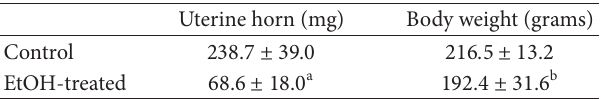
Table 1: Weight changes in uterine horn from rats receiving an alcohol containing liquid